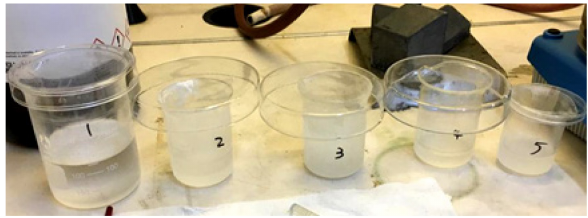
Fig. 3. Beakers containing PE (1-4) and C 2 D 4 dissolved in xylene